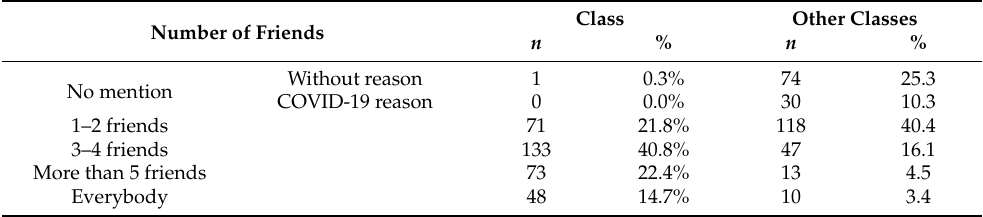
Table 6. Number of friends in primary school in the pandemic.